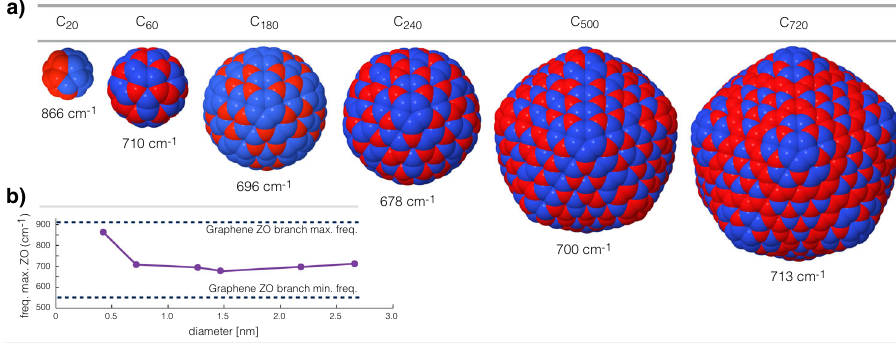
Fig. 5 Shape of the highest frequency ZO vibrational modes in the fullerene family. a Visualization of the highest frequency purely-radial vibrational modes, which correspond to the phonons in the ZO branch in graphene. The red and blue colors indicate phase and anti-phase radial atomic displacements, respectively. b Dependence of the corresponding vibrational frequencies versus the fullerenes ’ diameter. The dashed lines indicate the frequency limits of the ZO branch in graphene.